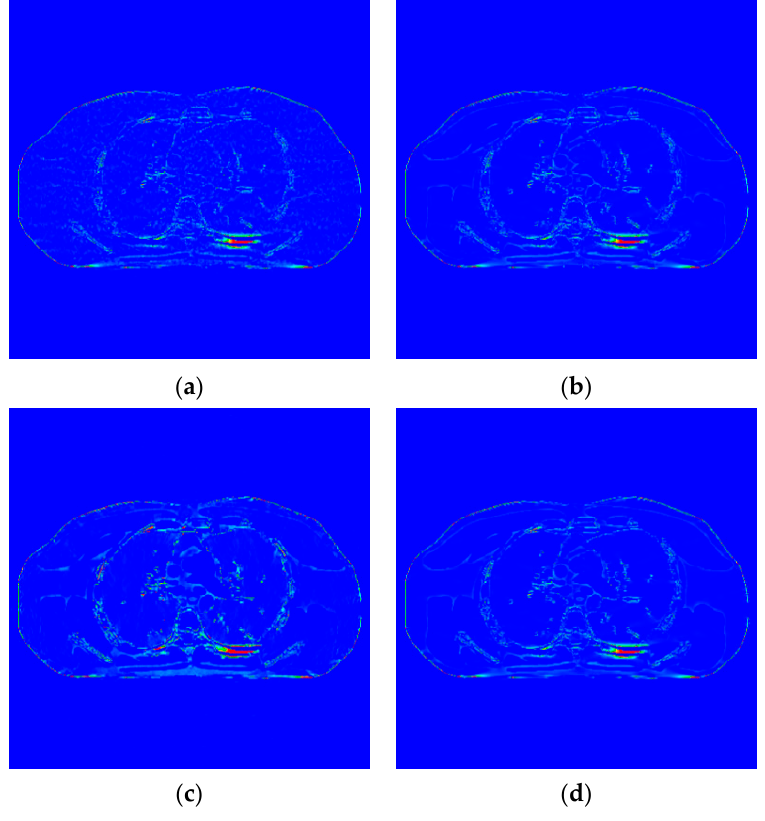
Figure 6. Image of difference of incident photon number 10 5 . ( a ) EP iterative reconstruction; ( b ) DCT image post-processing; ( c ) DL iterative reconstruction algorithm; ( d ) learning sparse transform.